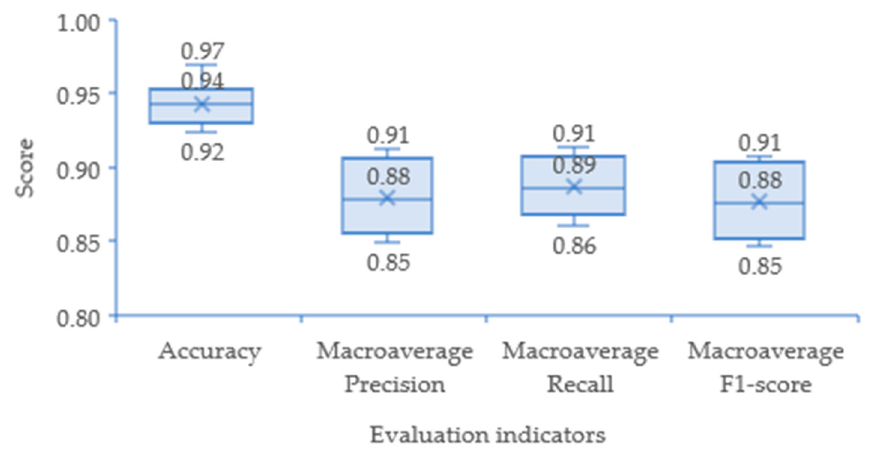
Figure 7. Data distribution of the settlement results of the four indicators for criterion validity. ‘ × ’ in the figure represents the average value.